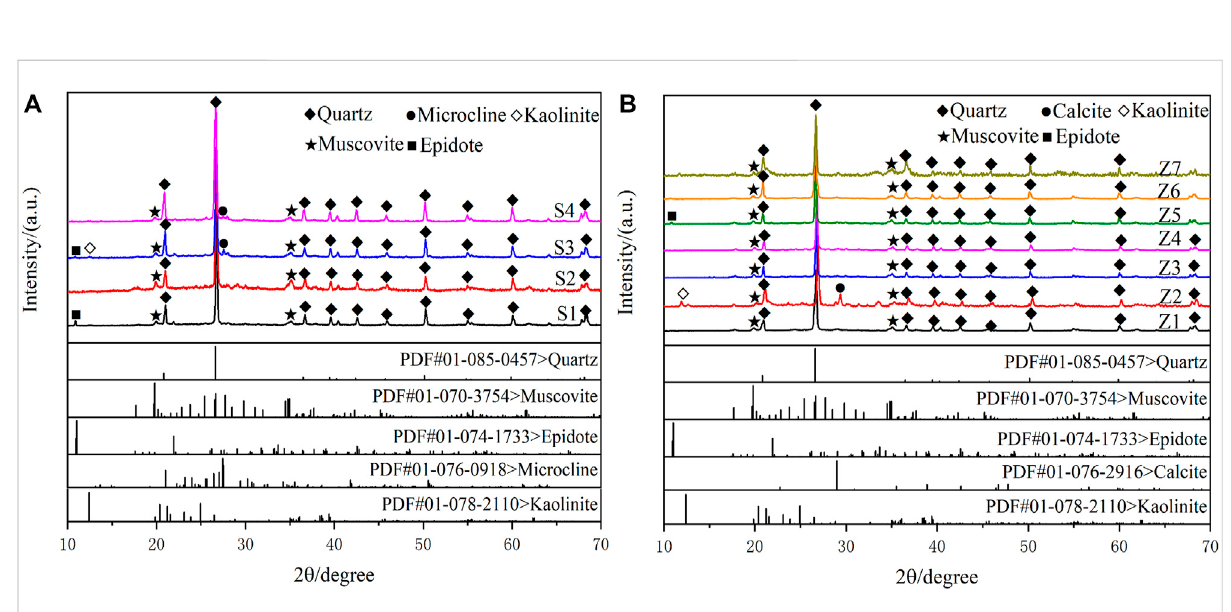
FIGURE 5 The X-ray diffraction patterns of soils, tailings, and sludge. (A) is the XRD patterns of soil samples (S1 – S4); (B) is the XRD patterns of tailing (Z1 – Z6) and sludge samples